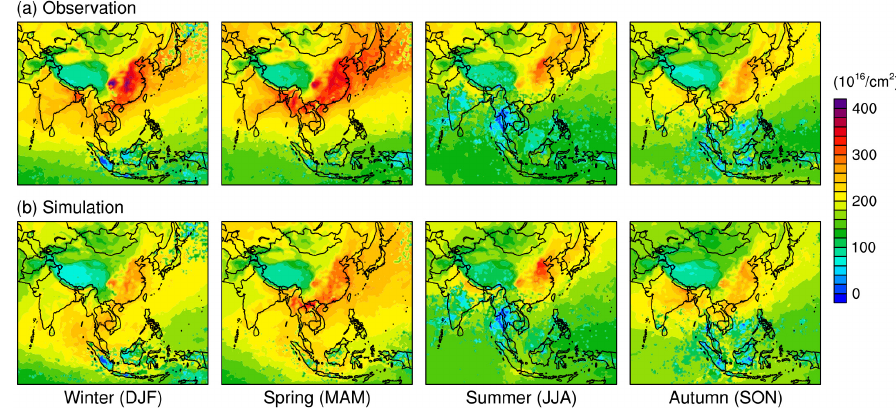
Figure 7. Horizontal distributions of observed and simulated seasonal mean total column CO in BASE for